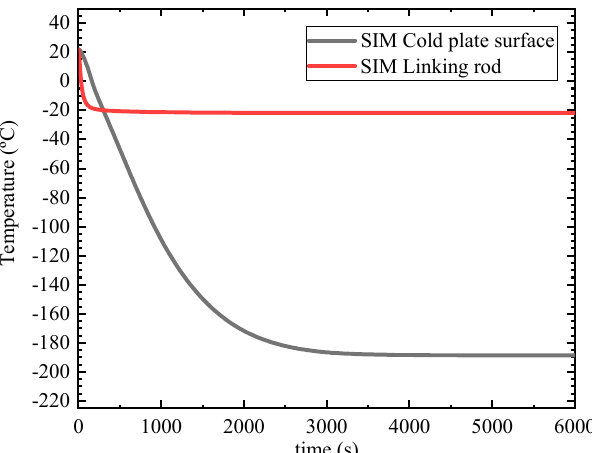
Figure 7. Simulated temperature variation versus time for top surface (averaged value) and for middle section element of one linking rod.